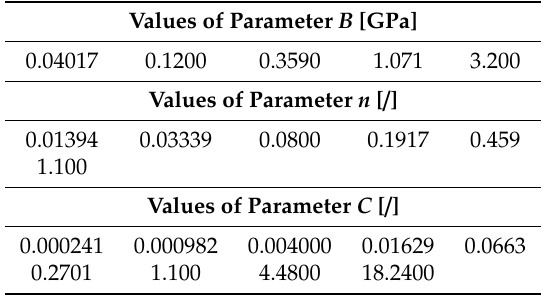
Table 4. Parameter levels for the full-factorial experiment (FFE).